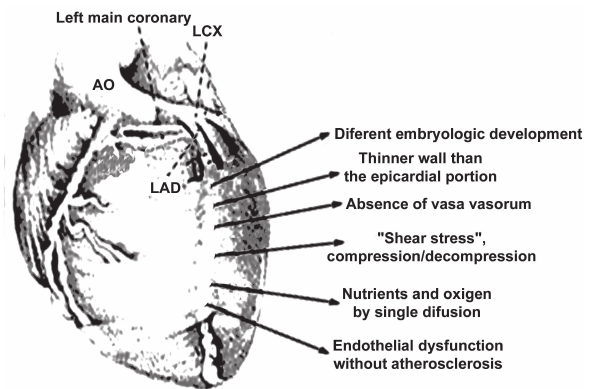
Fig. 2 – Main anatomofunctional and embryological aspects